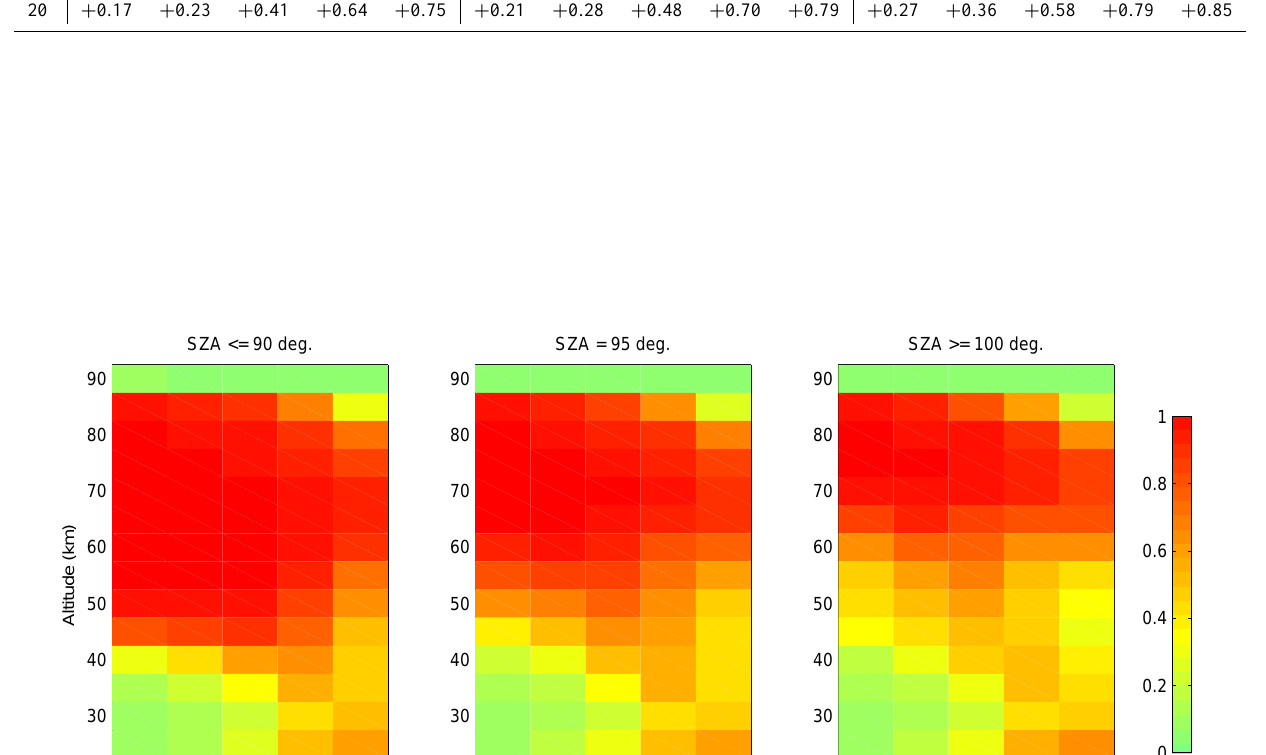
Fig. A3. P H /Q for January